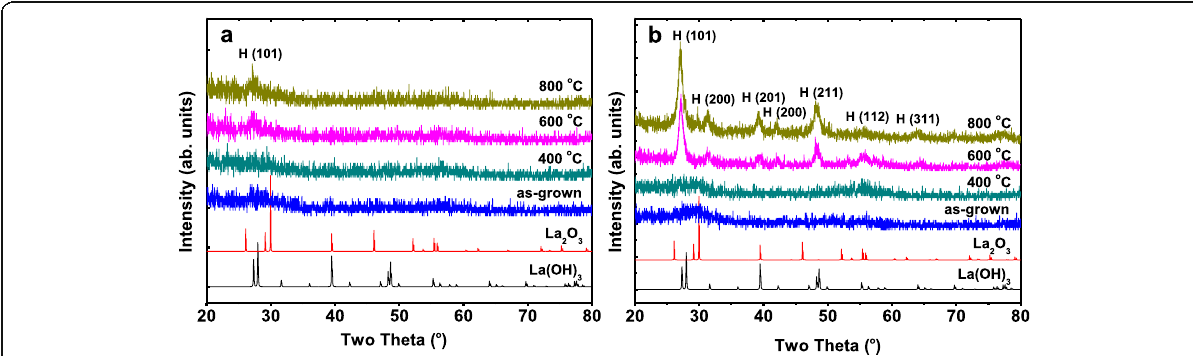
Fig. 5 GIXRD diffractograms for as-grown and annealed La 2 O 3 after being exposed to air for 48 h. a 10 nm La 2 O 3 films annealed at 600 °C and b 20 nm La 2 O 3 films annealed at 600 °C. Hexagonal La 2 O 3 and hexagonal La(OH) 3 patterns are added for